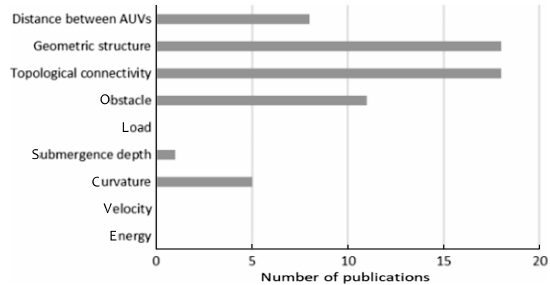
Fig. 9 Number of papers that consider different